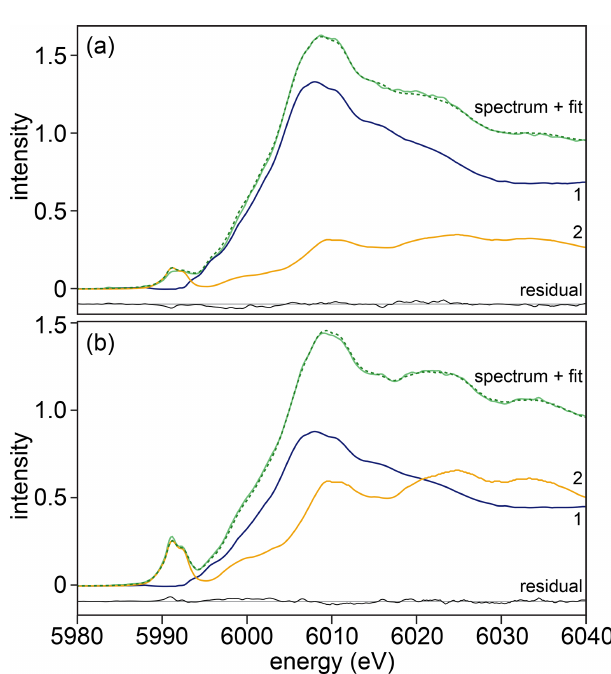
Figure 9. Examples of Cr K-edge XANES spectra (light green, solid line) recorded at (a) 5µm and (b) 505µm from the interface of sample HYCRa5. The spectra were fitted (dark green, dashed line) using a linear combination of end-members 1 (blue) and 2 (yellow). The residual is shown in black.